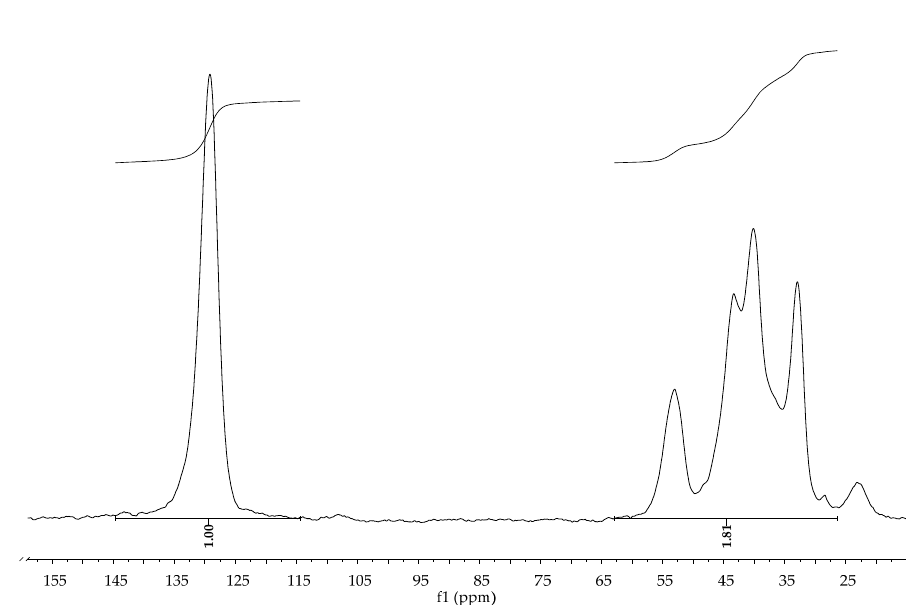
Figure 3. 13 C CPMAS spectra of PDCPD obtained from the reaction of 1 /AgBF 4 /DCPD (Table 6, entry 1) in CH 2 Cl 2 .